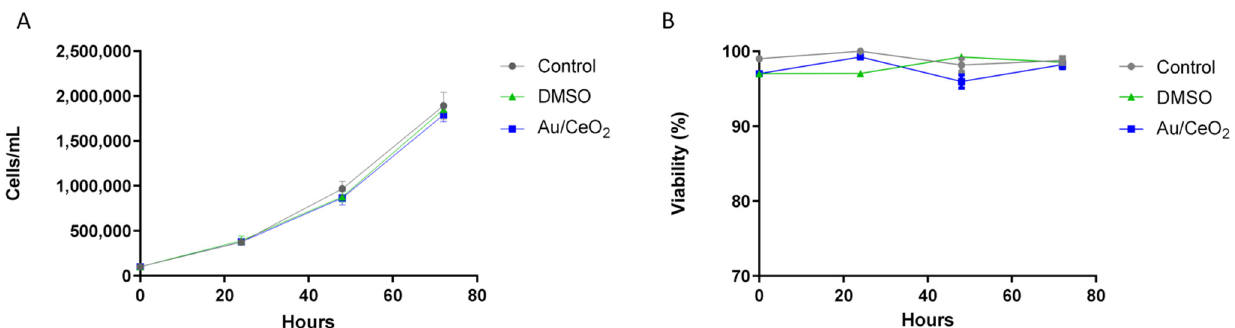
Figure 7. Determination of cellular proliferation and viability. Effect of Au/CeO 2 and its vehicle DMSO on U937 cell line. ( A ) Cell count over 3 days revealed no difference in cellular proliferation between each condition over the course of the experiment (72 h). ( B ) Cell viability assessed with acridine orange and propidium iodide double stain.